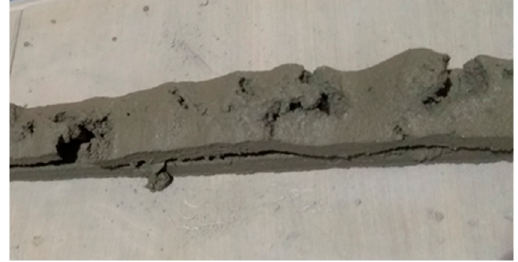
Figure 1. Defect in the printed foam concrete.